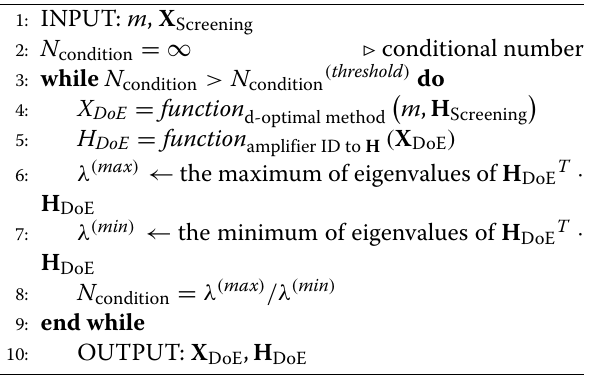
Table 6 Simulation results and cost function in the optimization problem (21) Optimization method